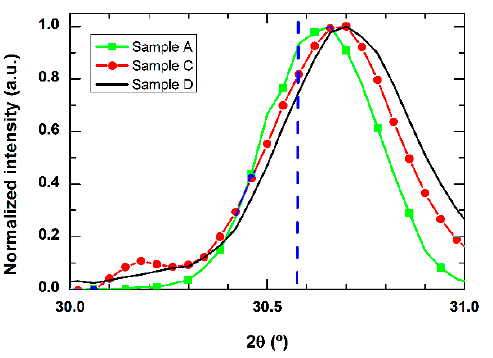
Figure 8. Magnification of the (2 2 2) peak for different XRD spectra of the evaluated samples. The line indicates the position of the In 2 O 3 NWs corresponding peak.